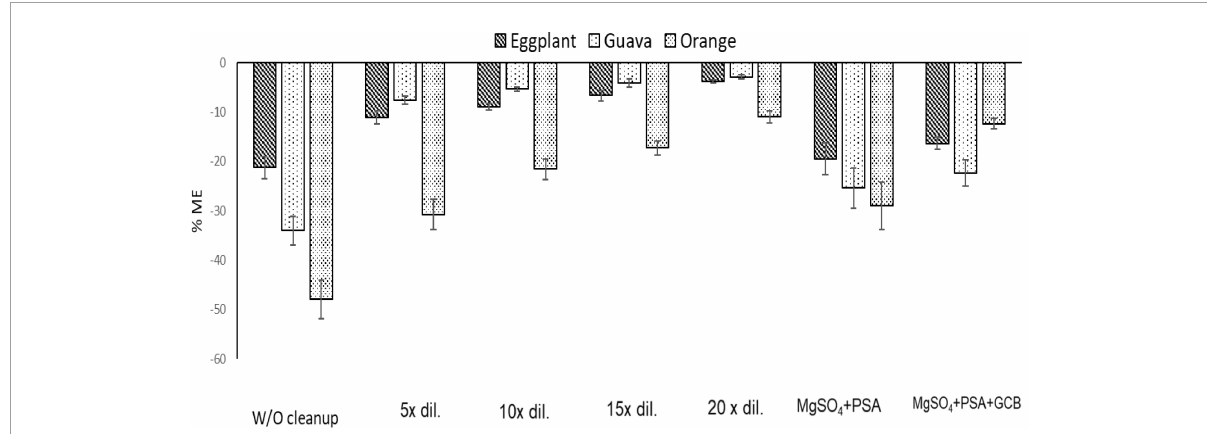
FIGURE5 Estimation of the % matrix effect (ME) in eggplant, guava, and orange ( n = 3) using four dilution and two cleanup, W/O Cleanup:% ME of matrix extracts without cleanup. 5 × dilution:% ME of matrix extracts after five times dilution. 10 × dilution:% ME of matrix extracts after 10 times dilution. 15 × dilution:% ME of matrix extracts after 15 times dilution. 20 × dilution:% ME of matrix extracts after 20 times dilution. MgSO4 + PSA:% ME of matrix extracts after cleanup with MgSO4 + PSA. MgSO4 + PSA + GCB:% ME of matrix extracts after cleanup with MgSO4 + PSA + GCB.